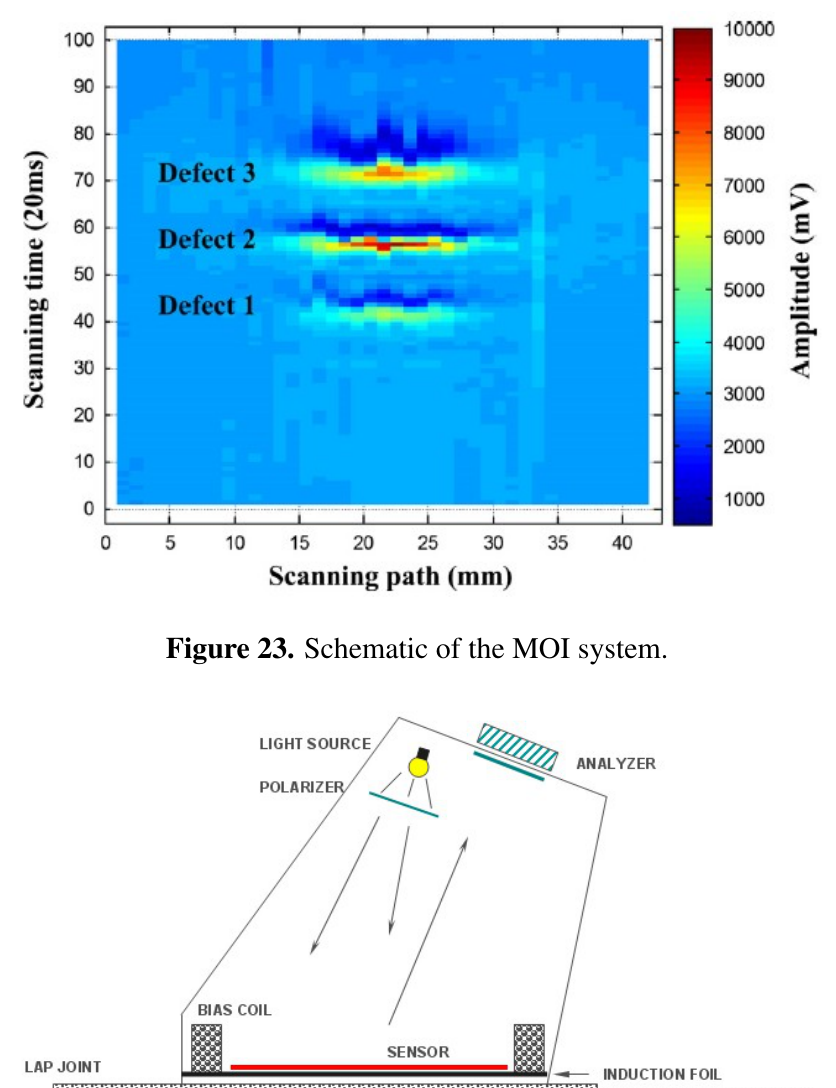
Figure 22. C-scan imaging results of three typical defects.